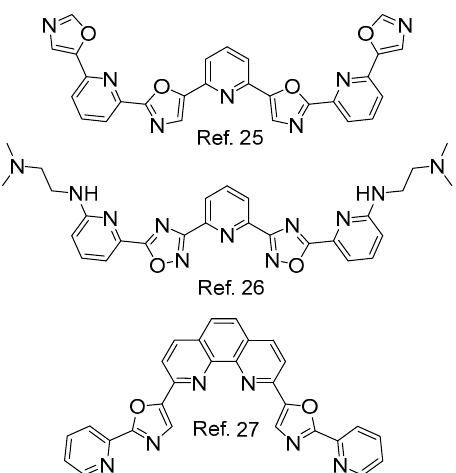
Figure 1. Representative examples of symmetric pyridine/oxazole-derived N , O -ligands for recognition of G-quadruplexes.